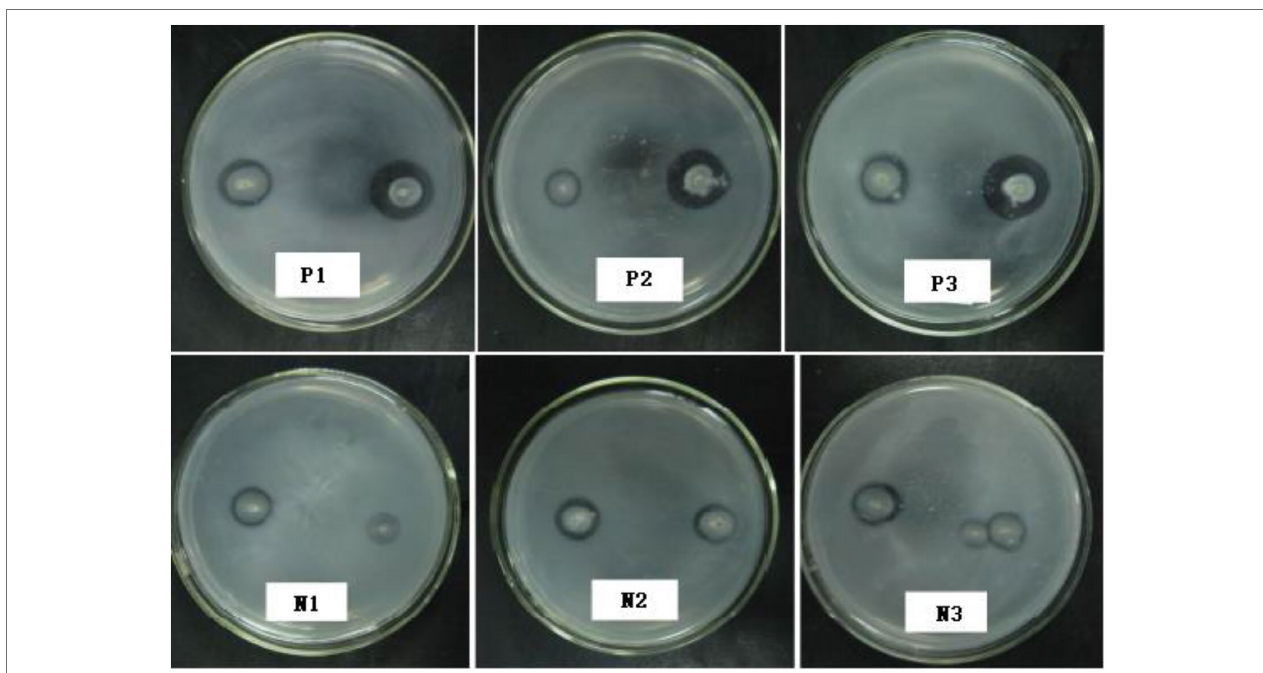
FIGURE 4 | Soluble (halo) zones of mutants after the second round of mutagenesis.